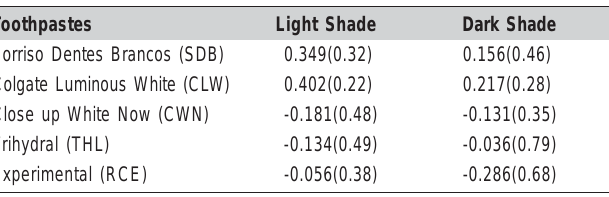
Table 3. Means (standard deviation) of surface roughness of artificial teeth (light and dark) subjected to alteration ∆ R a mechanical brushing with different dentifrices (2-way ANOVA, Bonferroni test,